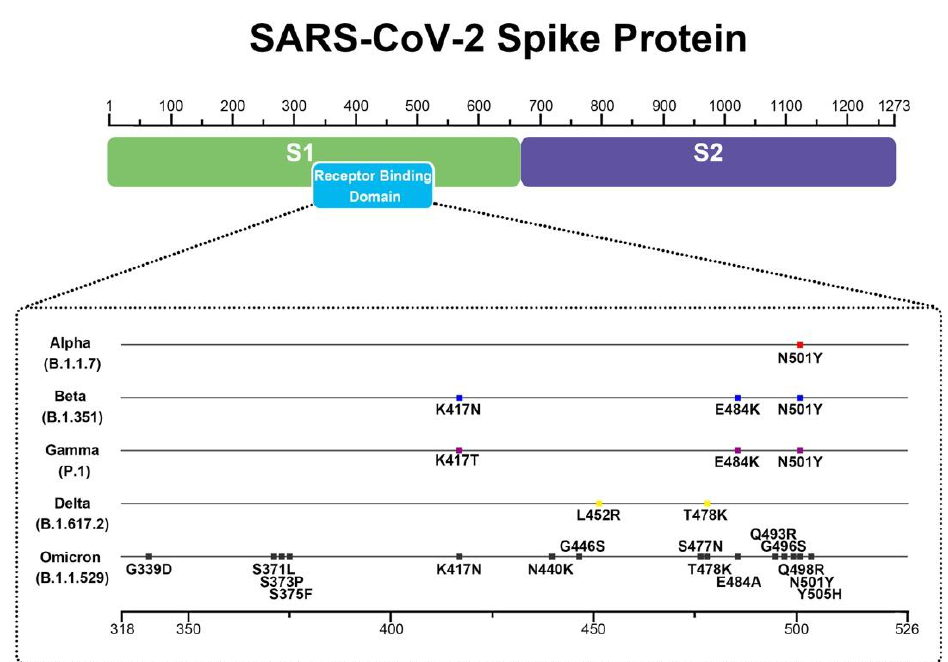
Figure 3. The RBD domain of SARS-CoV-2 spike protein showing the mutations in Alpha, Beta, Gamma, Delta and Omicron mutants.